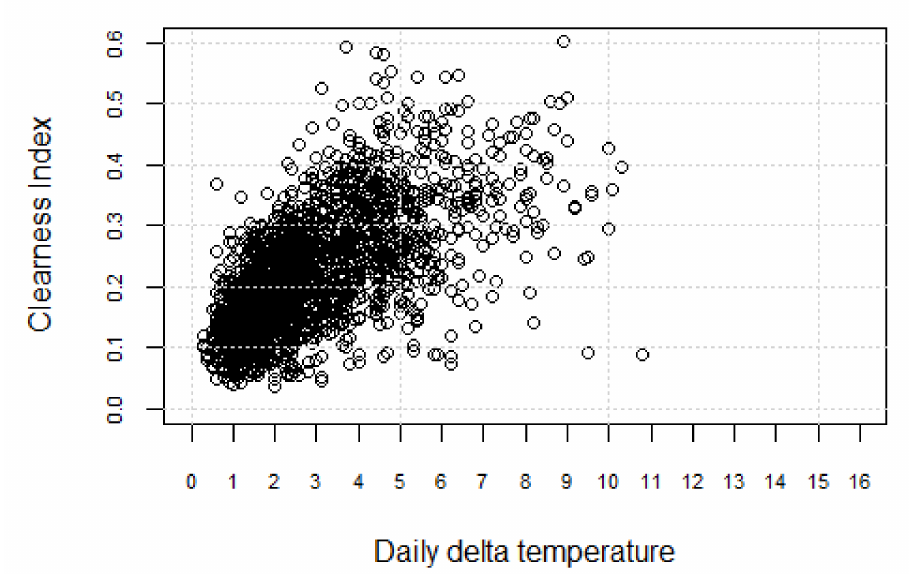
Figure 5. Daily delta of temperature–clearness index for Cerro P á